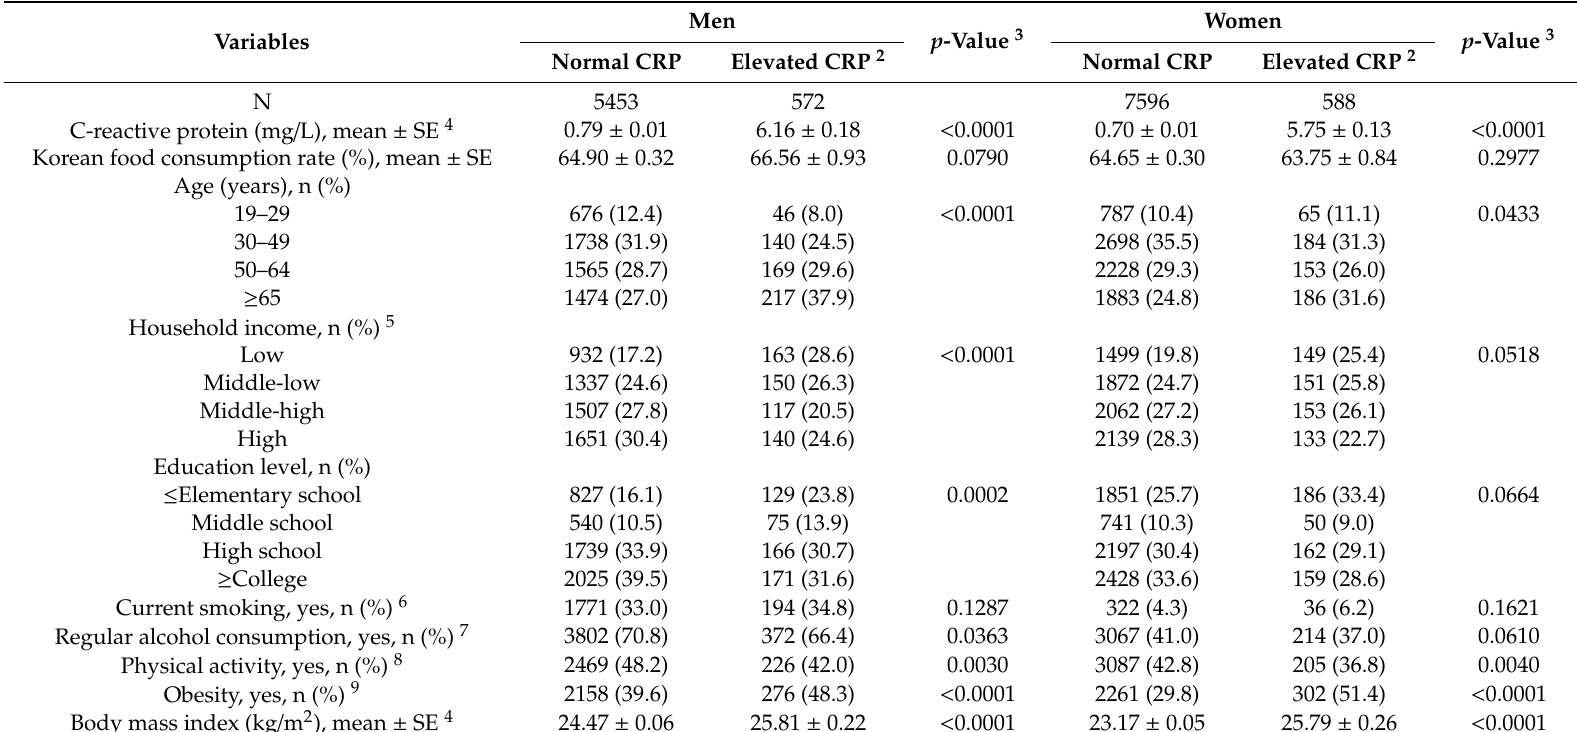
Table 1. General characteristics of subjects according to C-reactive protein (CRP) status 1